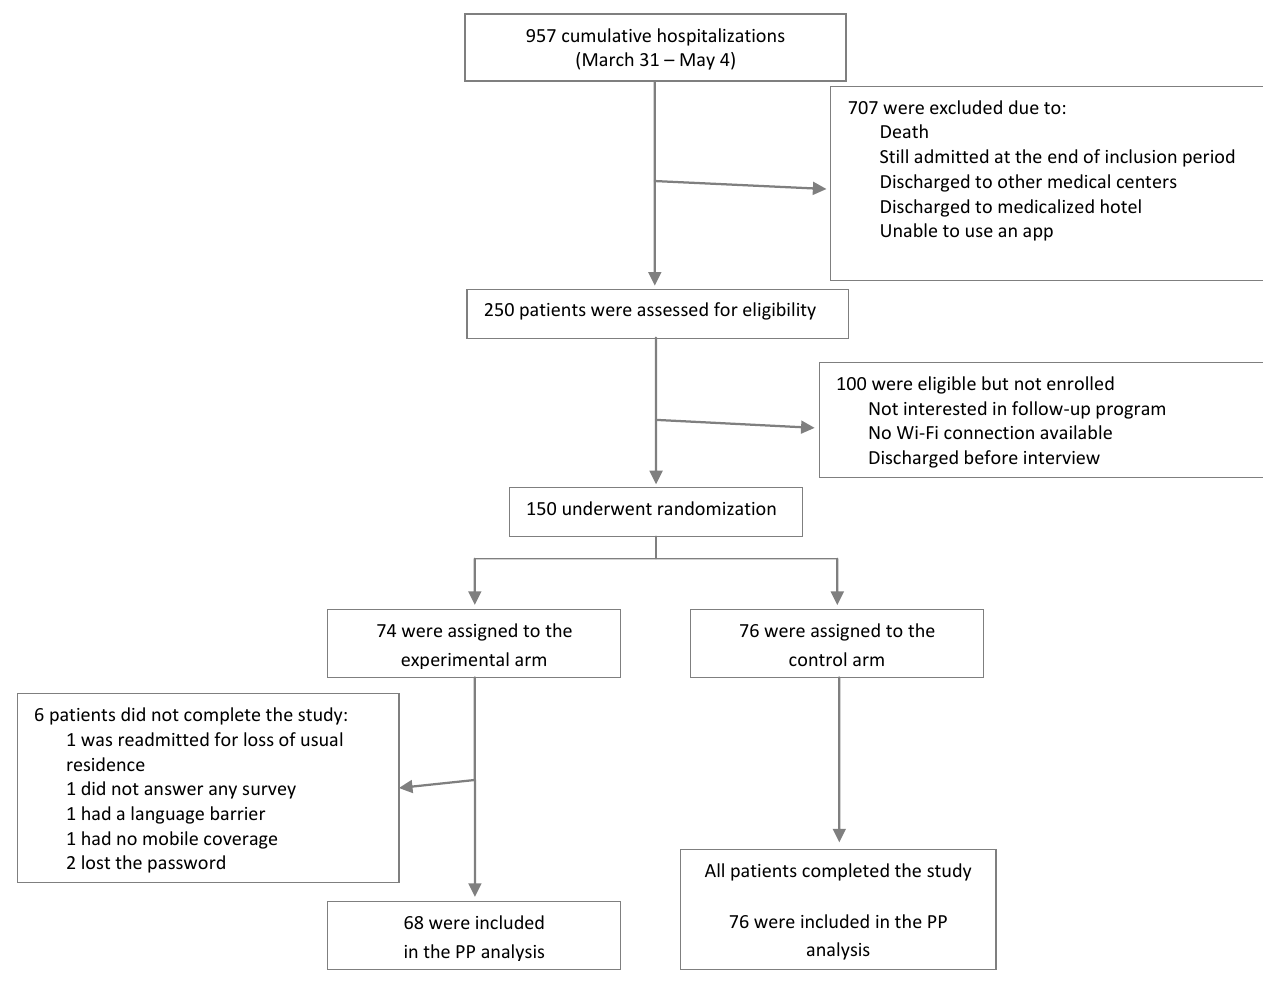
Figure 2. Enrollment and randomization